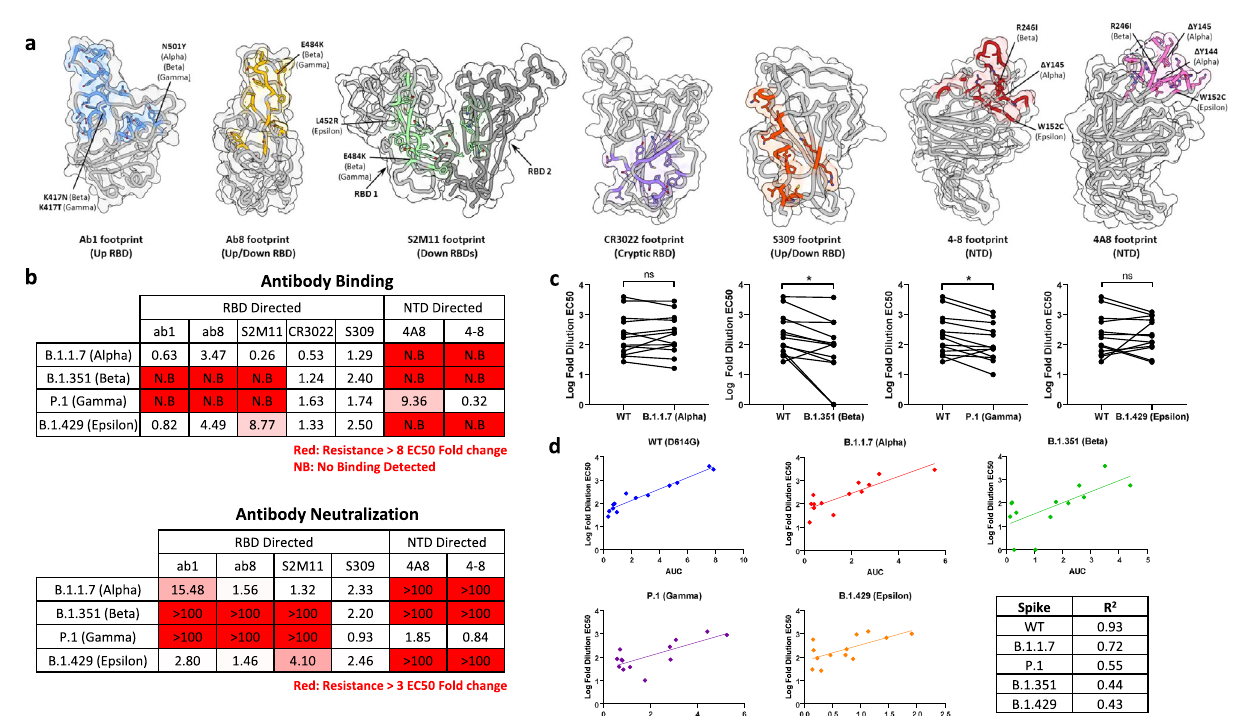
Fig. 2 | Alpha, Beta, Gamma, and Epsilon S proteins exhibit differences in monoclonal and polyclonal antibody escape. a Antibody-binding footprints for monoclonal antibodies included in the study. Variant S protein mutations falling withineachfootprintarehighlighted. b Fold-changesinantibodybinding(top)and pseudovirus neutralization EC50s (bottom) for each variant spike relative to wild- type(D614G).Antibodybinding wasquanti fi ed by ELISA. c Log-fold EC50dilutions of patient sera when neutralizing wild-type and variant spike pseudovirus. Statis- tical signi fi cance was tested via the Wilcoxon matched pairs test (* p ≤ 0.05, ns,